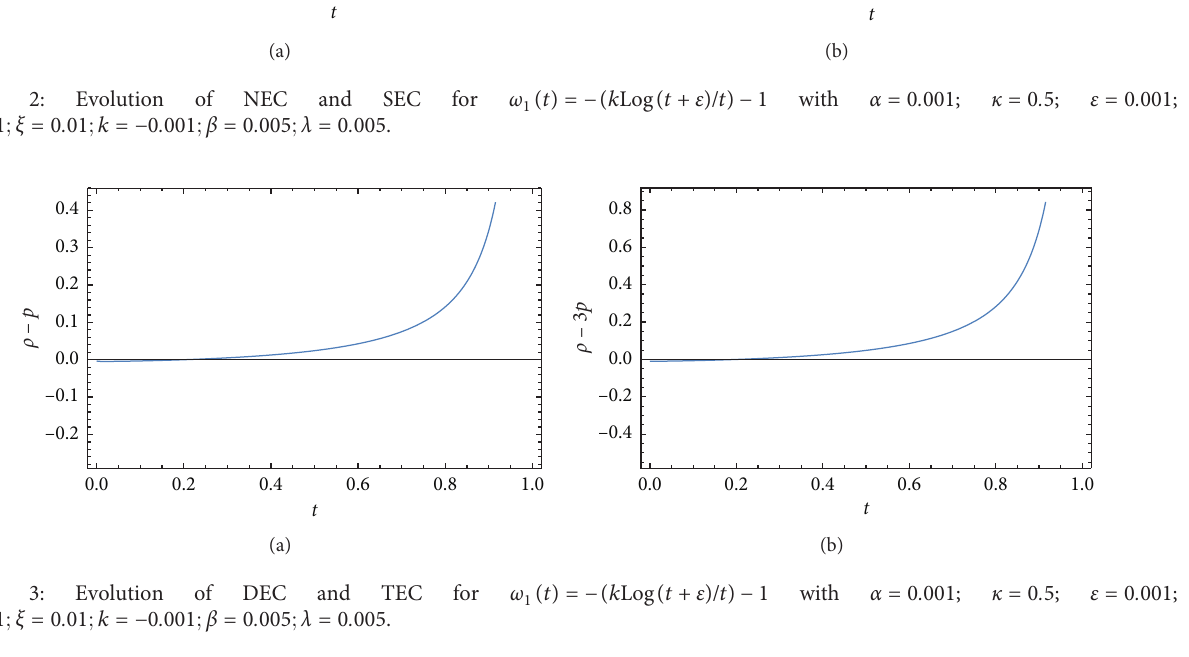
3: Evolution of DEC and TEC for with ζ � 0 . 01 ; ξ � 0 . 01 ; k � − 0 . 001 ; β � 0 . 005 ; λ � 0 . universe contracts to H > 0 when the universe expands and H � 0 when the bouncing point occurs. This feature of a bouncing model in our case is evident from the left plot of Figure 5. The deceleration parameter q in cosmology is defined as